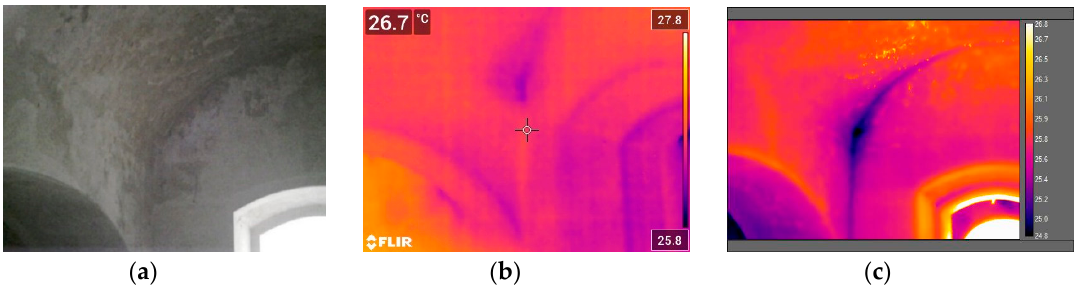
Figure 3. (Left to right) the set of images represent the left corner of the eastern arch in the lower ground oval eastern room. ( a ) Is the visual image of the area, ( b ) is the thermal image taken during the survey in August 2019, ( c ) is the thermal image taken during the survey in February 2020.